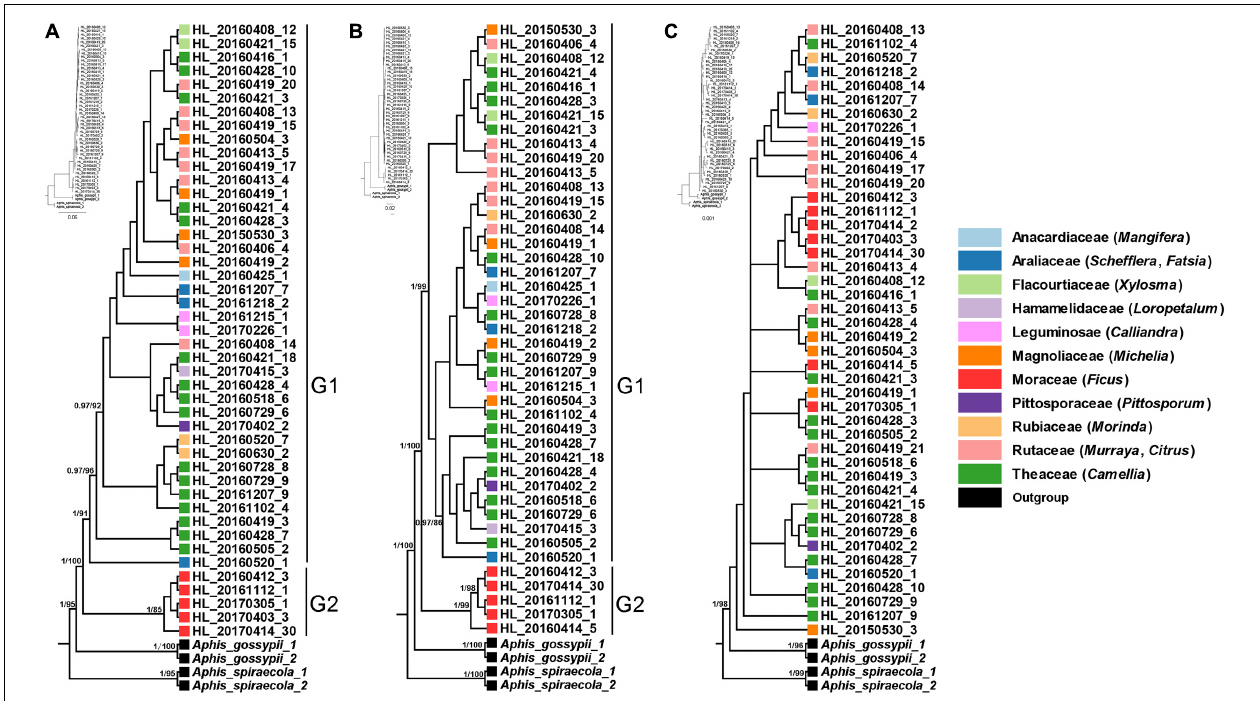
FIGURE 1 | Phylogeny of Aphis aurantii populations inferred from Bayesian analyses (BI) based on COI + Cytb (A) , gnd and 16S (B) and EF-1 α (C) . Different color represent samples from different host plant families. The bootstrap values ( > 80) and posterior probabilities ( > 0.9) are shown for main